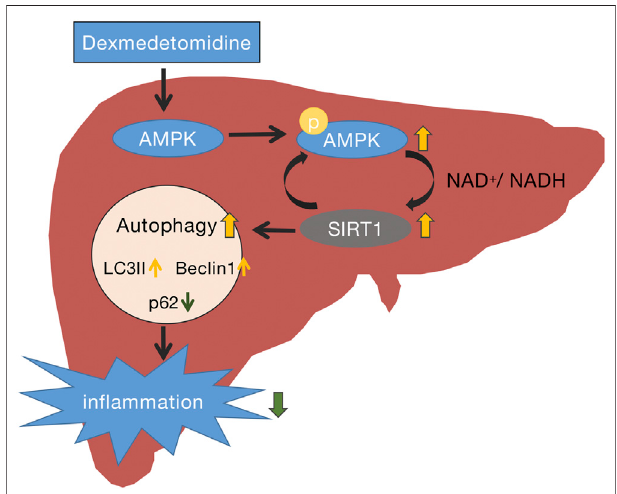
FIGURE 8 | Schematic representation of the potential protective mechanism of dexmedetomidine in liver injury induced by CLP through the AMPK/SIRT1/autophagy